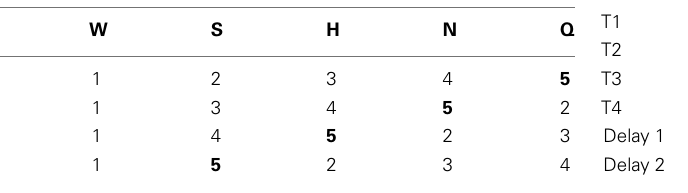
Table 3 |Taste-to-spout mapping for each